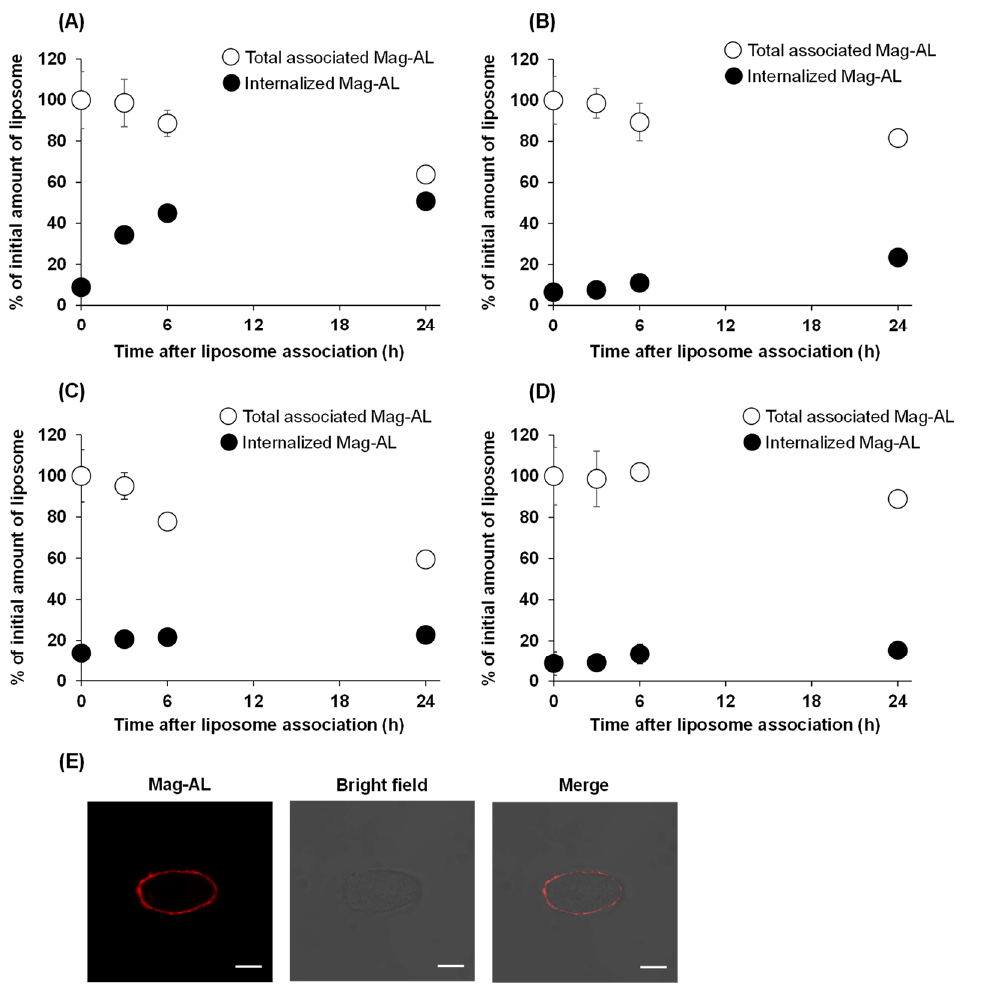
Figure 3. Cellular association and internalization of Mag-AL/ATCOL complexes in MSCs. Small- sized ( A , B ) or large-sized ( C , D ) Mag-AL/ATCOL complexes with 2 µg/mL ( A , C ) or 20 µg/mL ( B , D ) of ATCOL were added to each well and incubated for 30 min at 37 °C in the presence of a magnetic field. Then, the total associated or internalized amount of Mag-AL in MSCs were measured at pre- determined time points. Each value represents the mean ± SD ( n = 4). ( E ) Confocal images of MSCs loaded with large-sized Mag-AL/ATCOL complexes with 20 µg/mL of ATCOL. The complexes were added to MSCs and incubated for 30 min at 37 °C in the presence of a magnetic field. Then, the cells were collected and seeded in a glass bottom dish, followed by incubation for 1 h at 37 °C. The cells were observed using a confocal laser microscope. Scale bar: 10